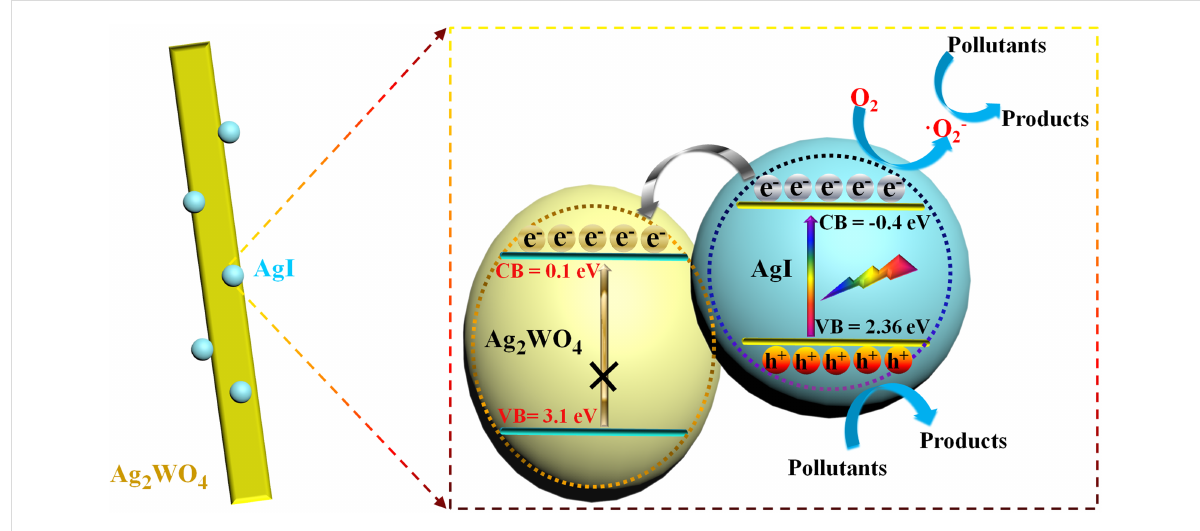
Figure 11: Schematic diagram of electron–hole pair separation and the possible reaction mechanism over the AgI/Ag 2 WO 4 heterojunction under visible-light irradiation.